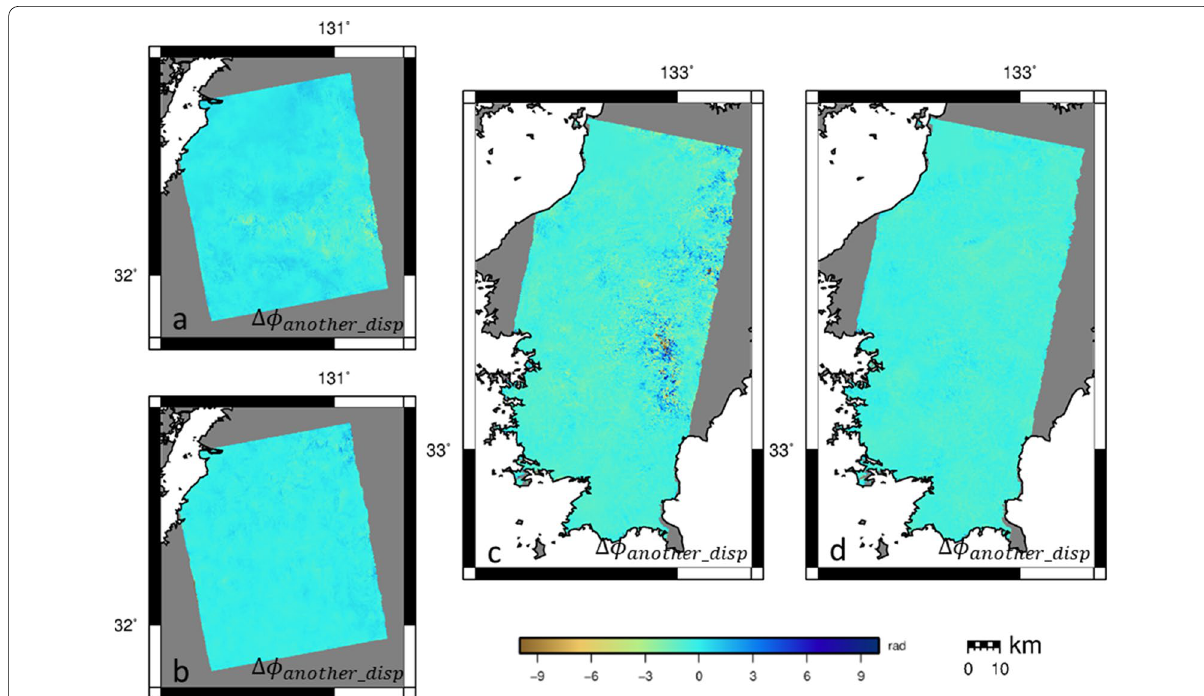
Fig. 8 �φ another_disp derived from triple-frequency SSM. a Kyushu 20180731_20180828 with heavy rain. b Kyushu 20180410_20180828 without heavy rain. c Shikoku 20180815_20181107 with heavy rain. d Shikoku 20180228_20181107 without heavy